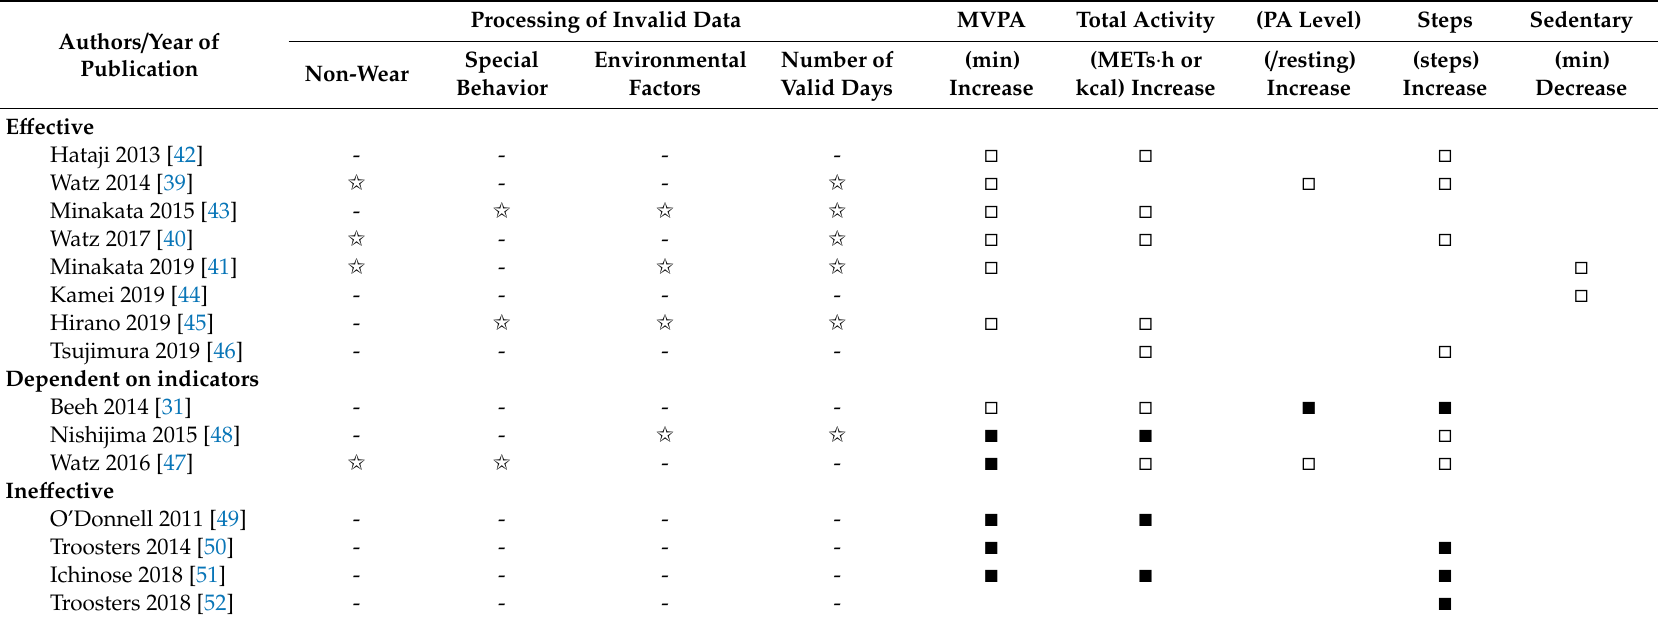
Table 4. Adjustment of influencing factors and e ff ectiveness of